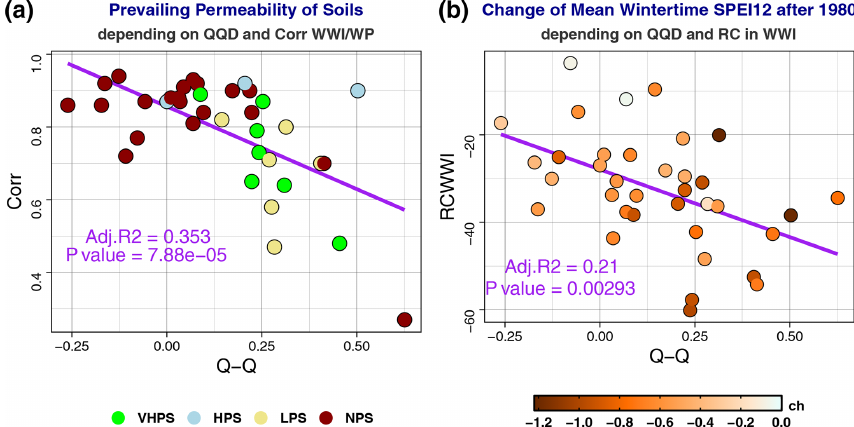
Figure 6. In panel (a) , symbols represent the relationship between quantile–quantile deviation (QQD; x axis) and the correlation estimated for WWI and WP ( y axis); the symbols are colour-coded by the prevailing type of soil in the catchment (permeability characteristics). Soils types are defined, based on their permeability conditions, in Sect. 2.1.3. In panel (b) , symbols represent links between QQD ( x axis) and the RC in WWI ( y axis); the symbols are colour-coded by the absolute change in mean wintertime SPEI12 before/after 1980. The purple line shows the linear regression between x – y variables, and the adjusted R 2 and p values are also